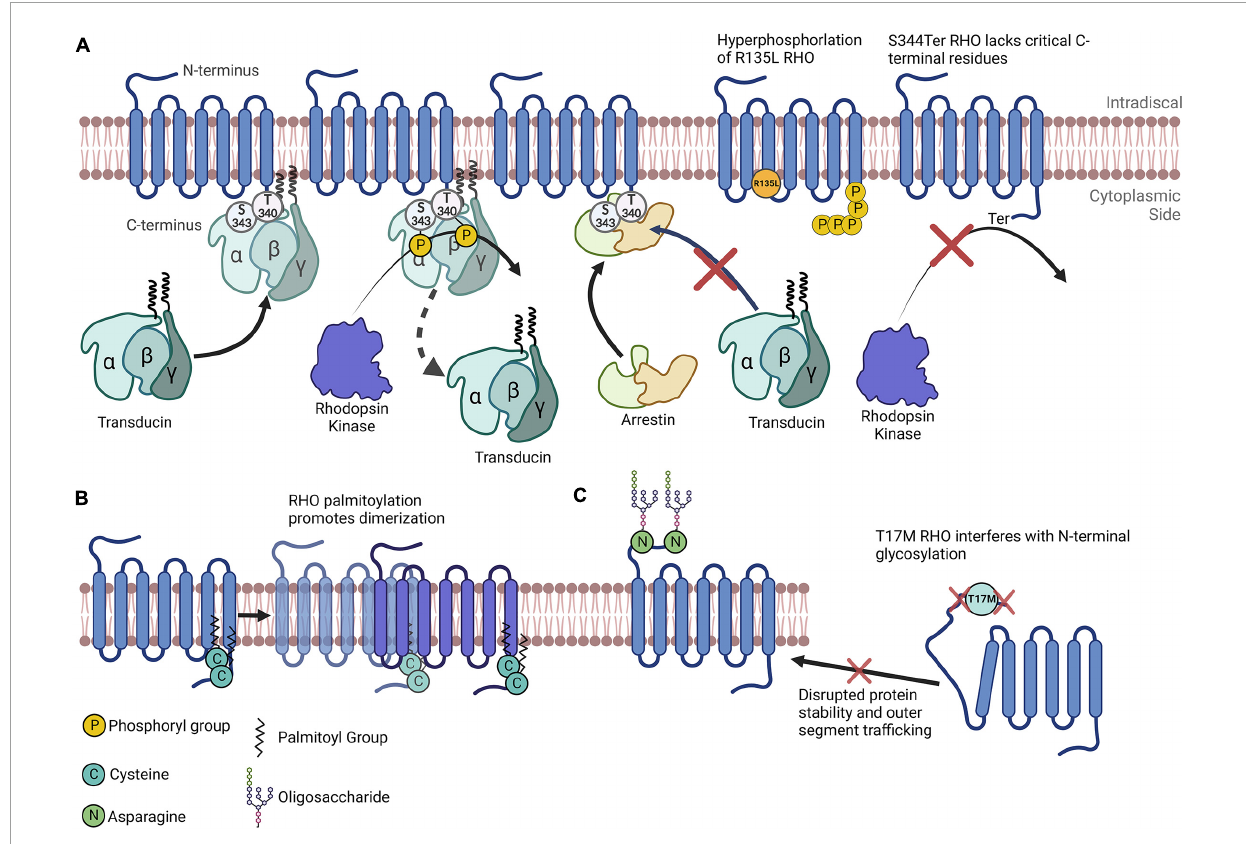
FIGURE1 Rhodopsin as a model for understanding the importance of posttranslational modifications. (A) Simplified depiction of rhodopsin phosphorylation. Transducin’s interaction with RHO is impeded by RHO’s phosphorylation by rhodopsin kinase at multiple C-terminal amino acids. Arrestin preferentially binds to RHO that has been phosphorylated. The R135L RHO mutation results in RHO hyperphosphorylation. S334Ter RHO lacks many C-terminal residues and therefore lacks critical phosphorylation sites. (B) RHO is palmitoylated at two C terminal cysteines that promotes